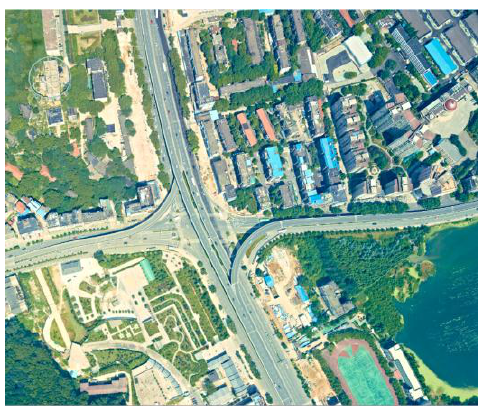
Figure 1. Overview of the Zhuodaoquan Viaduct